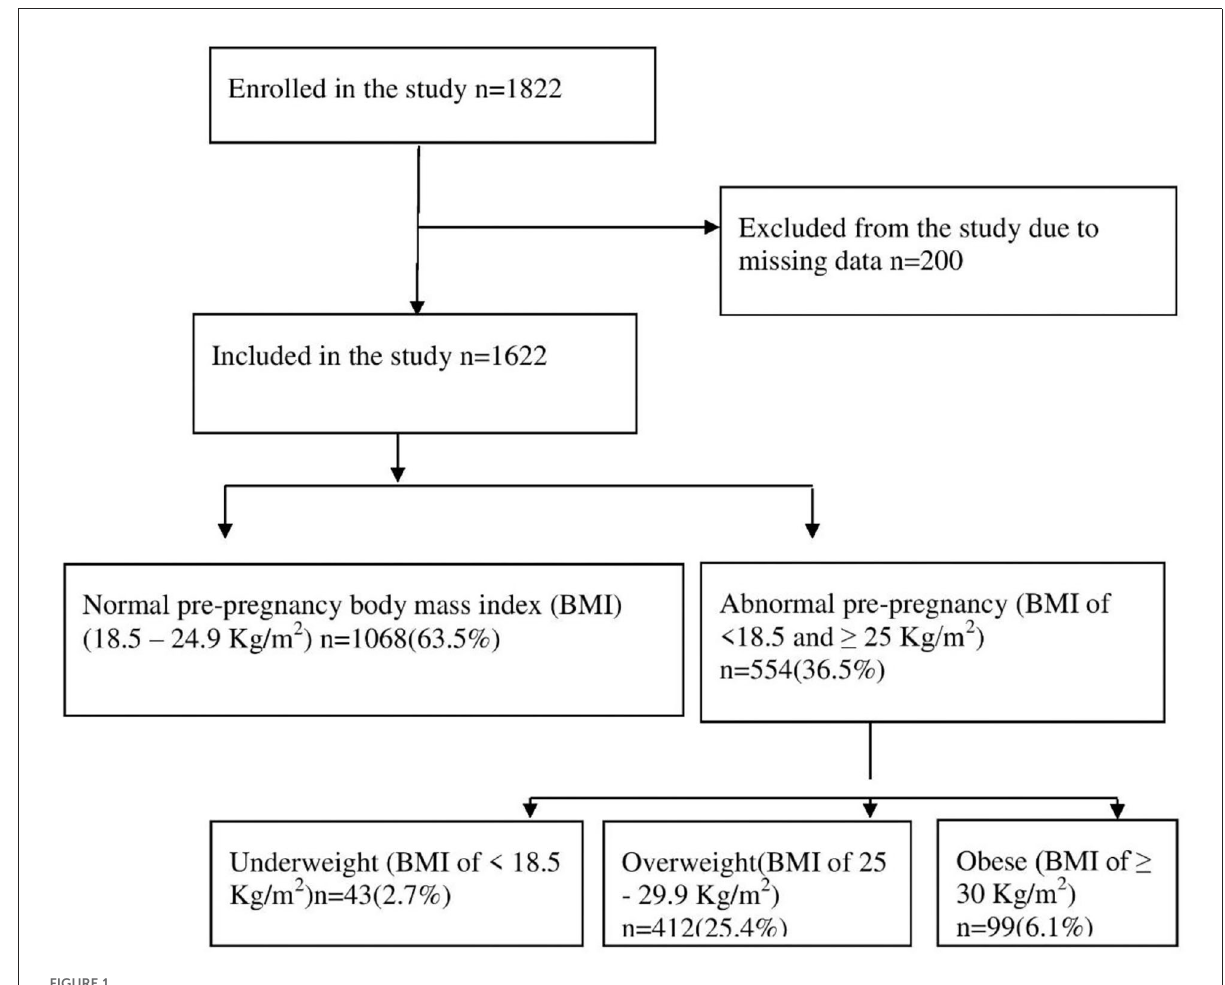
FIGURE1 Flowchart of the study participants and the main